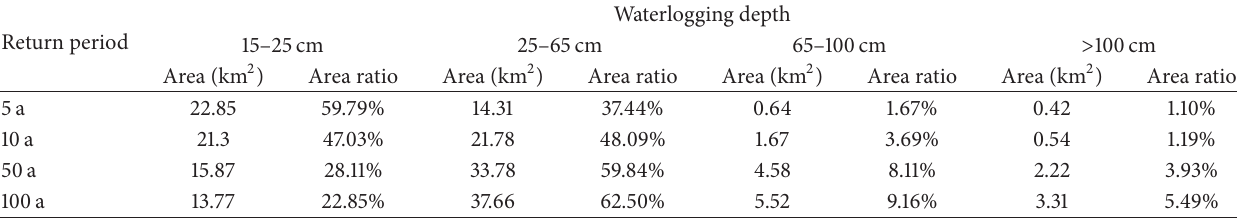
Figure 8: Distribution map of waterlogging sampling points. 1: Xihu Road; 2: Hongdu socks factory dormitory; 3: intersection of Jingdong Da Dao and Huoju 2 Road; 4: intersection of Jingdong Da Dao and Changye Road. Table 8: The table of effect of waterlogging.